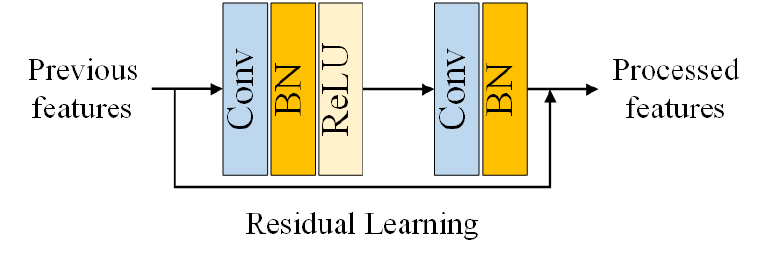
Figure 5. The original Residual Block